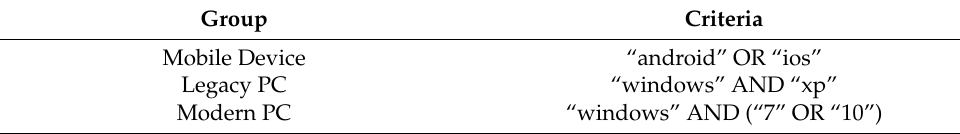
Table 1. Group-forming